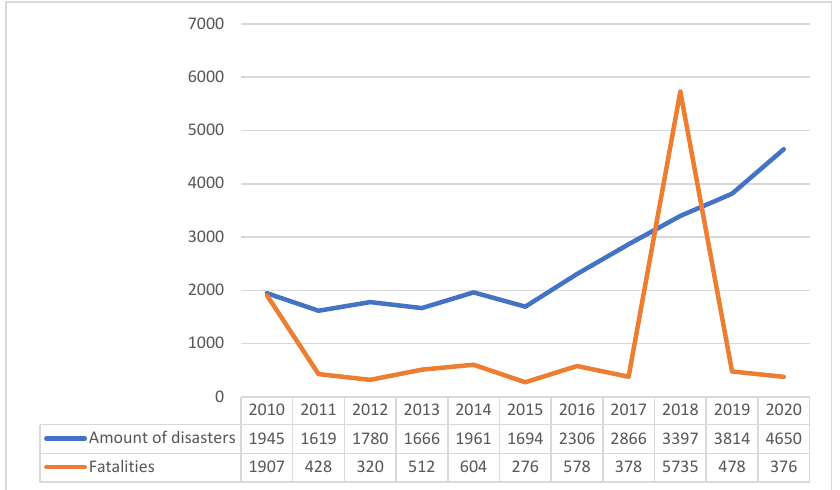
Figure 1. The number of natural hazards, including flood, tornado, landslide, earthquake, forest and land fire, tidal and abrasion and volcanic eruption, as well as their fatalities in Indonesia between 2010 and 2020 [15–25].